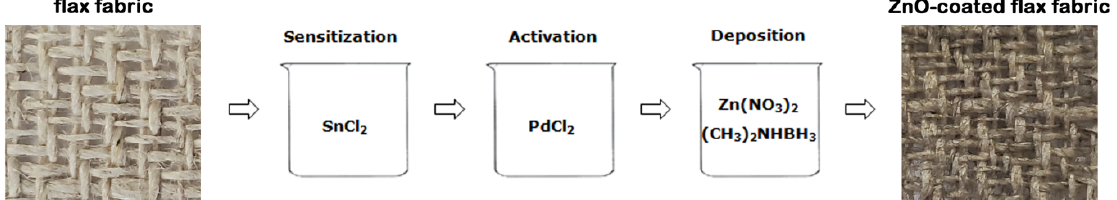
Figure 1. Schematic representation of the steps involved in the functionalization of the flax fabrics by ZnO electroless deposition .